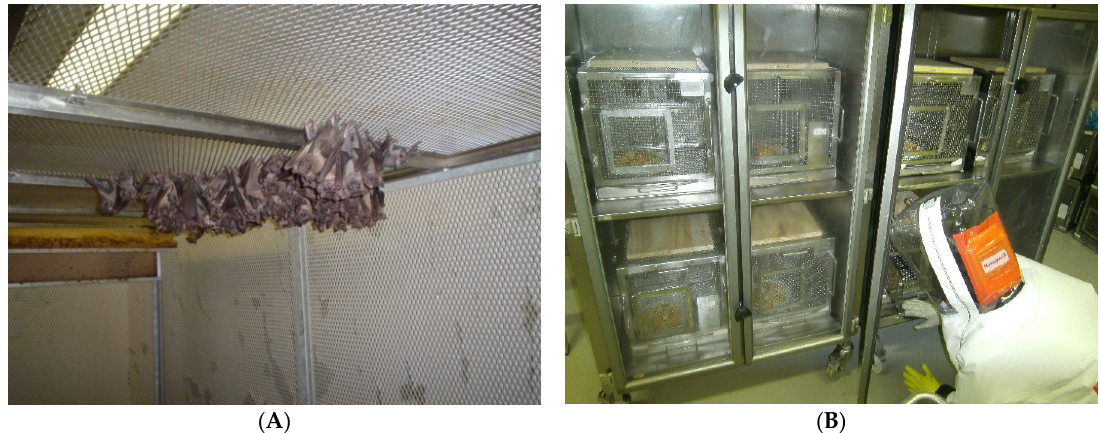
Figure 5. R. aegyptiacus colony in flight cage ( A ). Negative pressure HEPA ‐ filtered animal isolators (Techniplast, West Chester, PA, USA) with custom designed stainless steel cages for housing bats in BSL4, NICD ‐ NHLS, Johannesburg, South Africa; untreated wooden planks placed on the celling of cages serving as a roosting substrate for laying bat fly pupae ( B ).